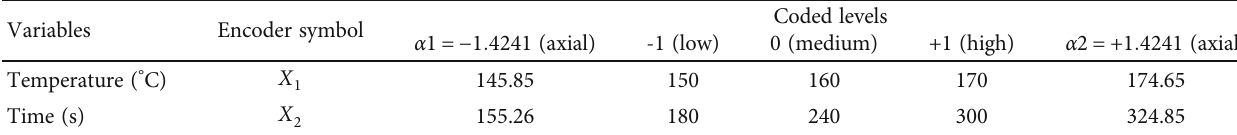
Table 2: Rotational composite central design matrix (CCD-R) with axial points and coded center points: atmospheric frying. Variables